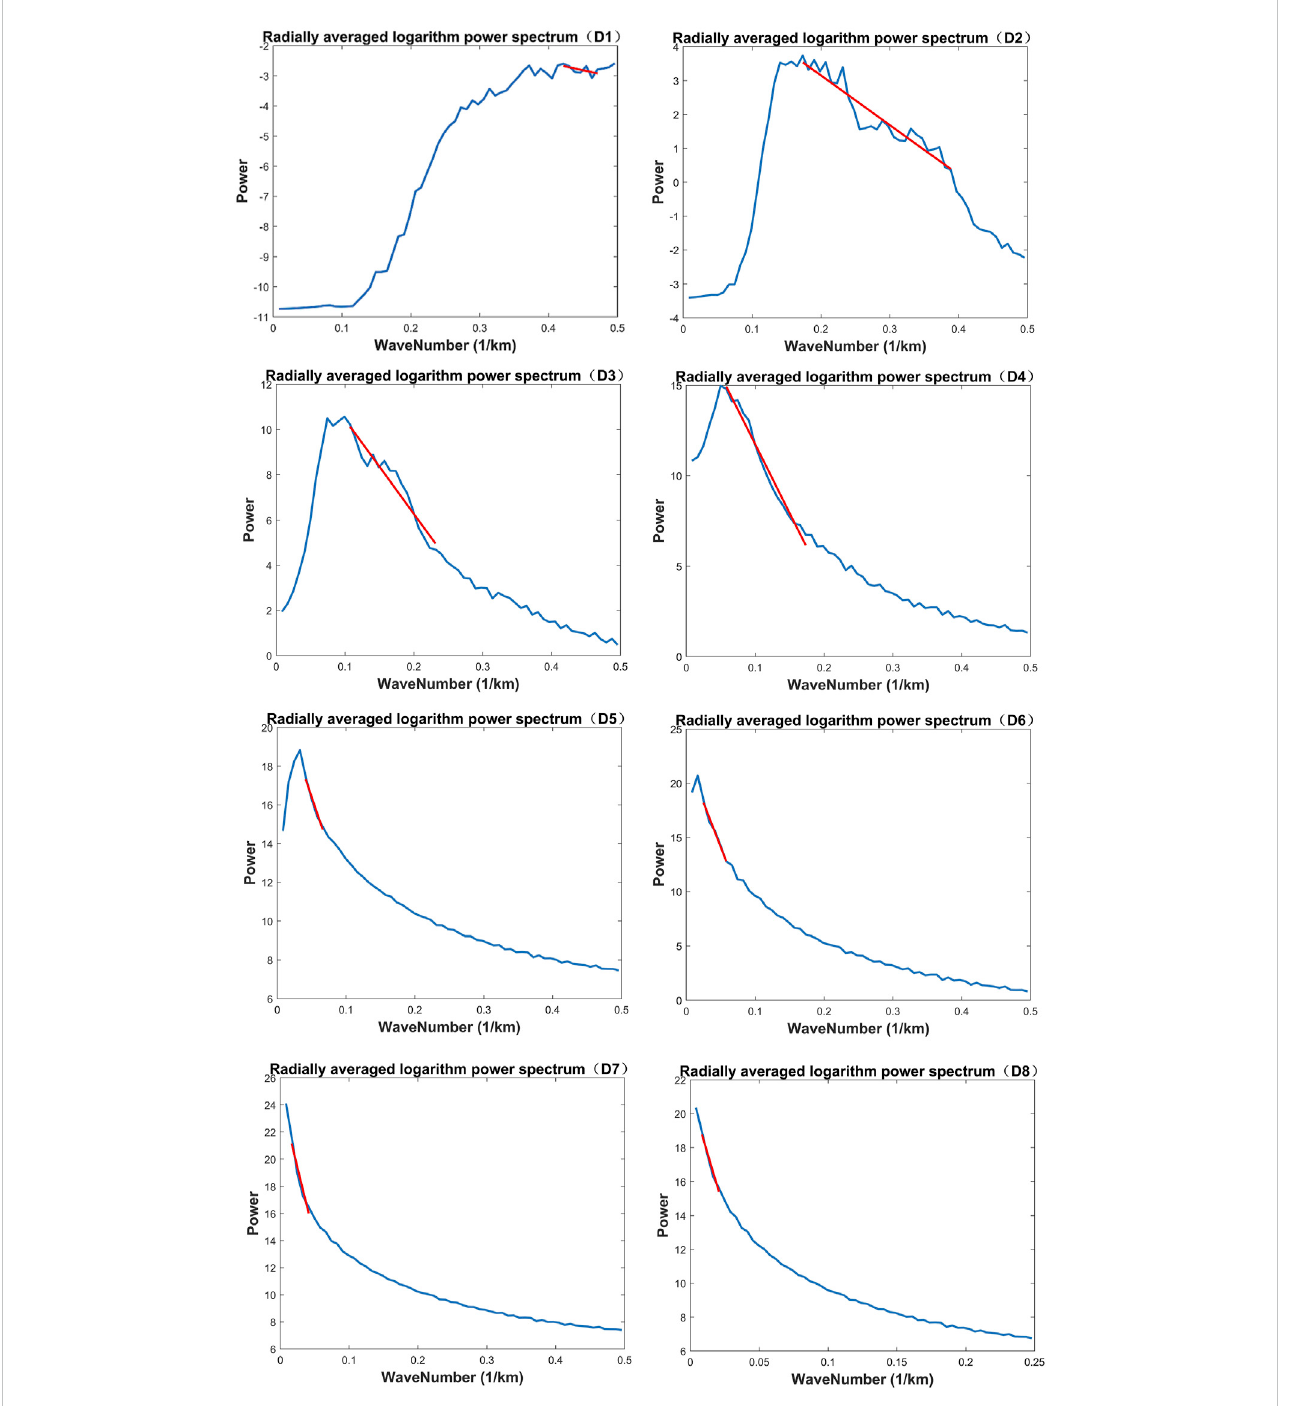
FIGURE 4 Radial logarithm power spectrum of the decomposed gravity anomalies D1 — D8 in the Mare Serenitatis. The estimated mean fi eld source depths of D1 — D8 are shown in Table 1 and on the left bottom of each corresponding fi gure in Figure 3.